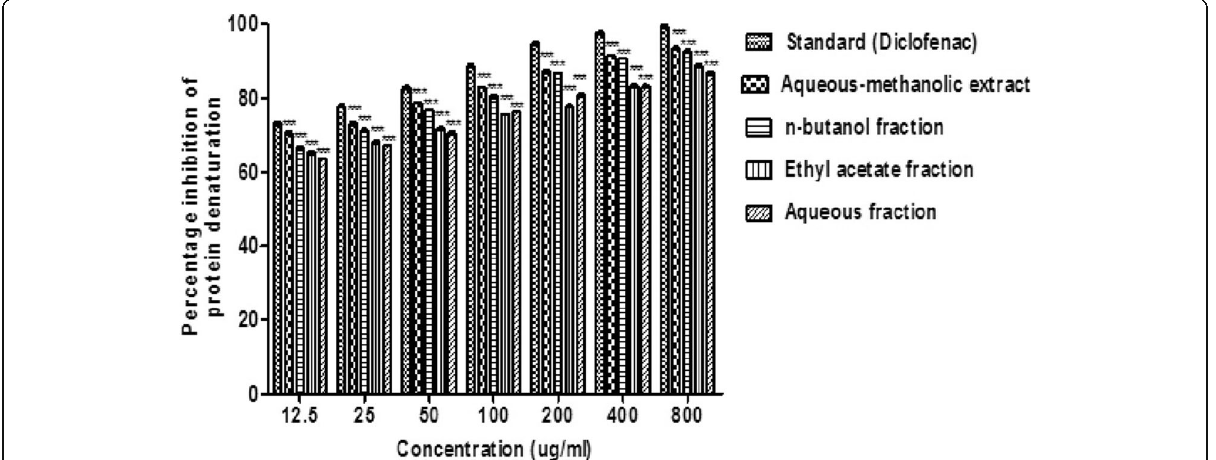
Fig. 2 Effect of B.orthobotrys aqueous-methanolic extract and fractions on protein denaturation using egg albumin. All the values are expressed as mean ± SEM ( n = 3), using two way ANOVA followed by Bonferroni posttest. *** = p < 0.001 vs diclofenac